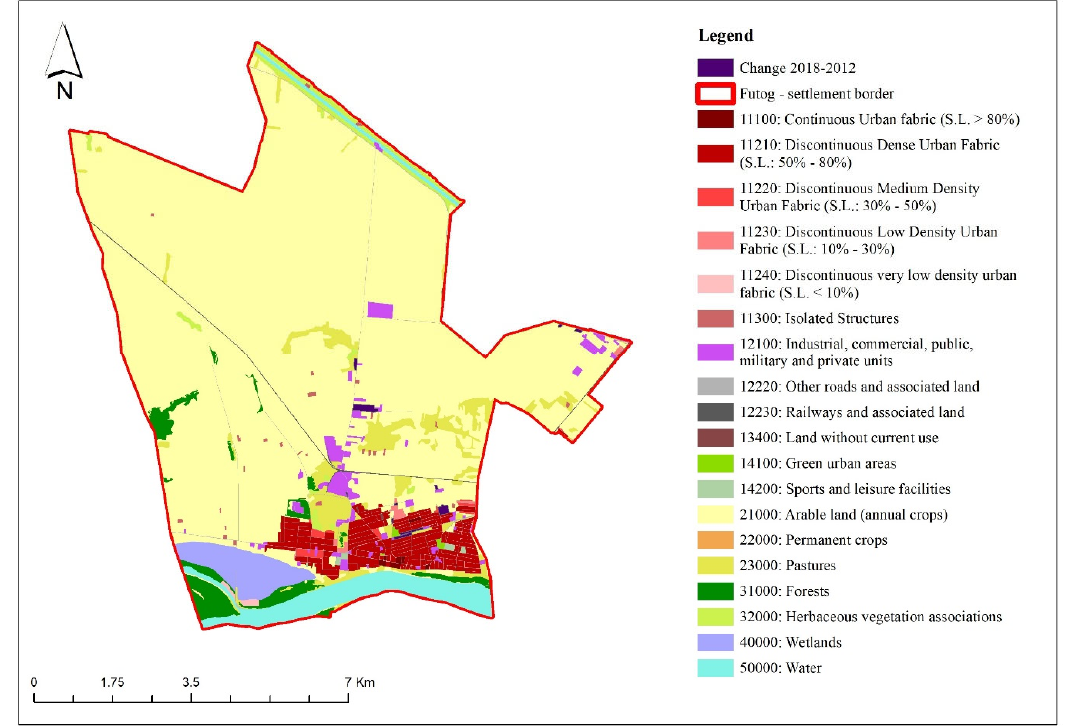
Figure 4. Spatial distribution of land take in the Futog settlement for the period 2012–2018.